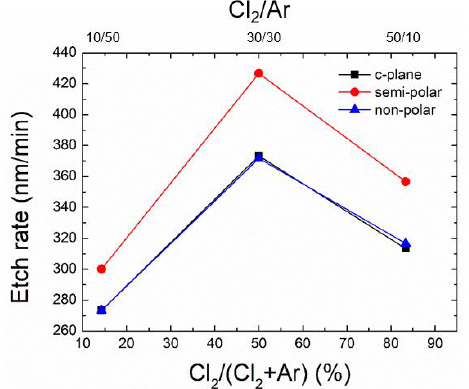
Figure 3. Etch rate of the c -plane, ( 112̅2 ) semi-polar and ( 112̅0 ) the non-polar GaN layers as a function of the Cl 2 /Ar ratio.